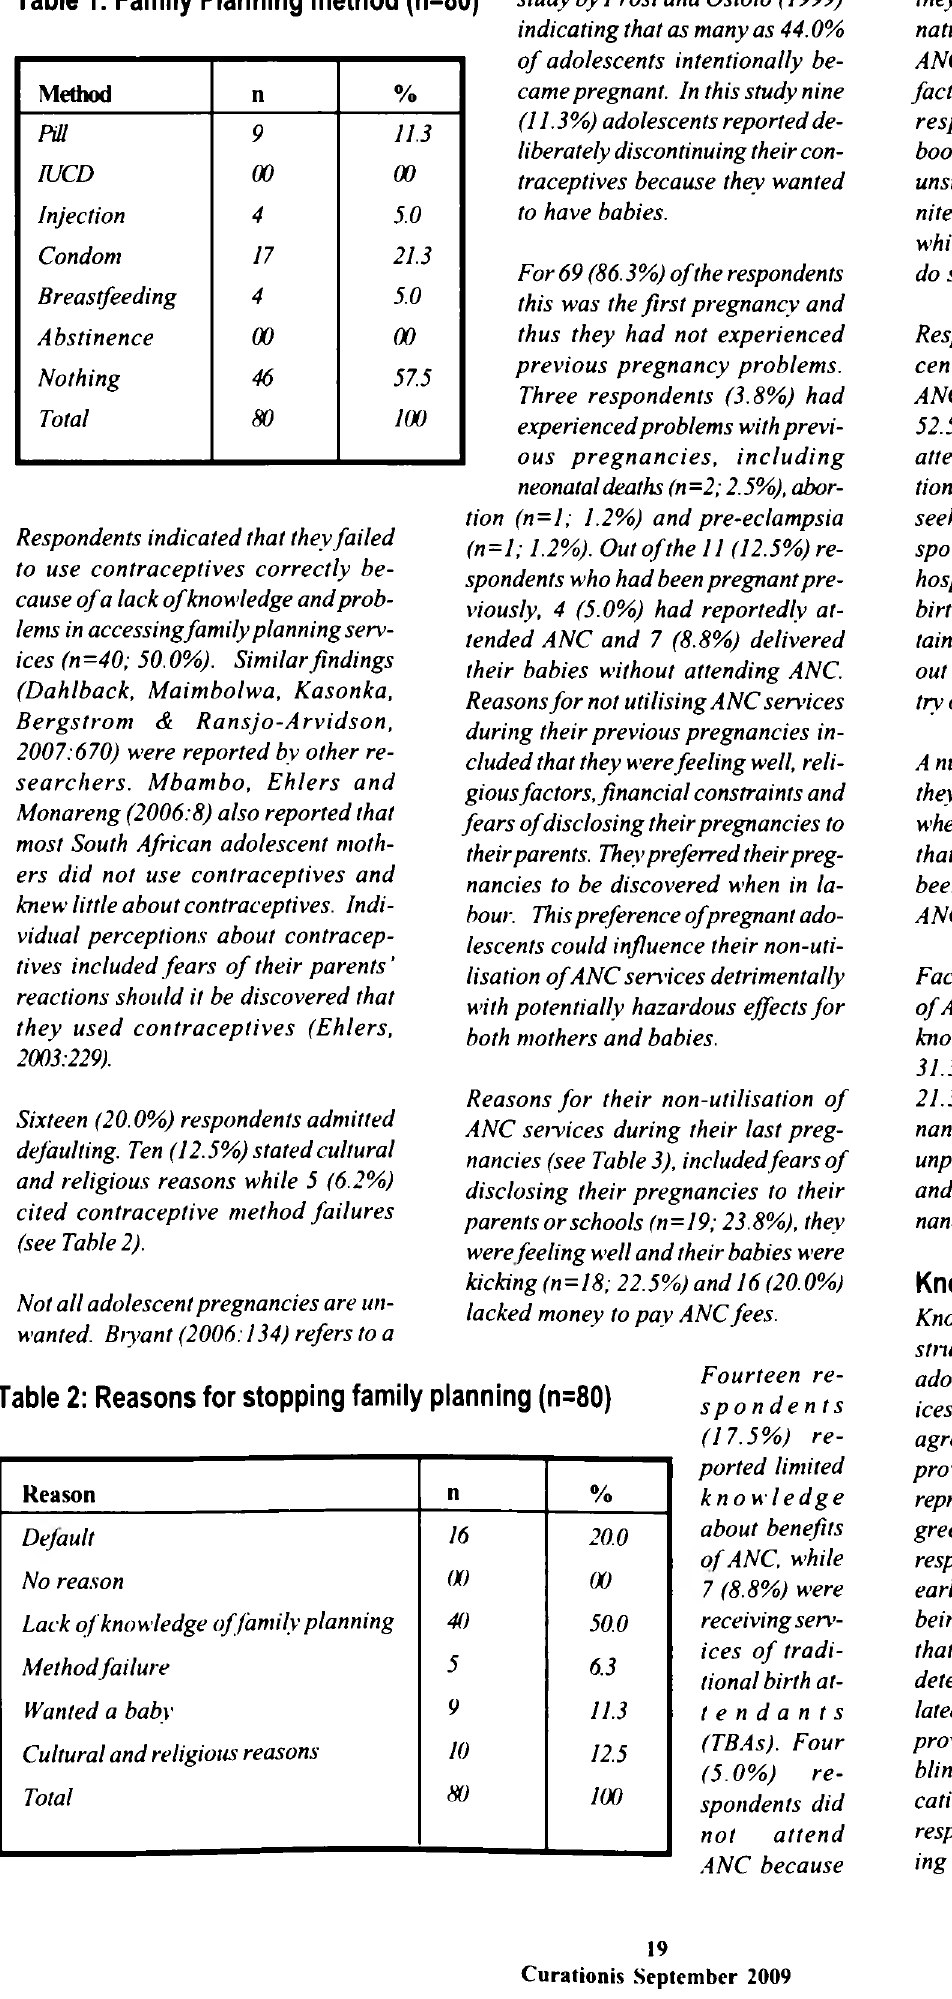
Table 1: Family Planning method (n=80)